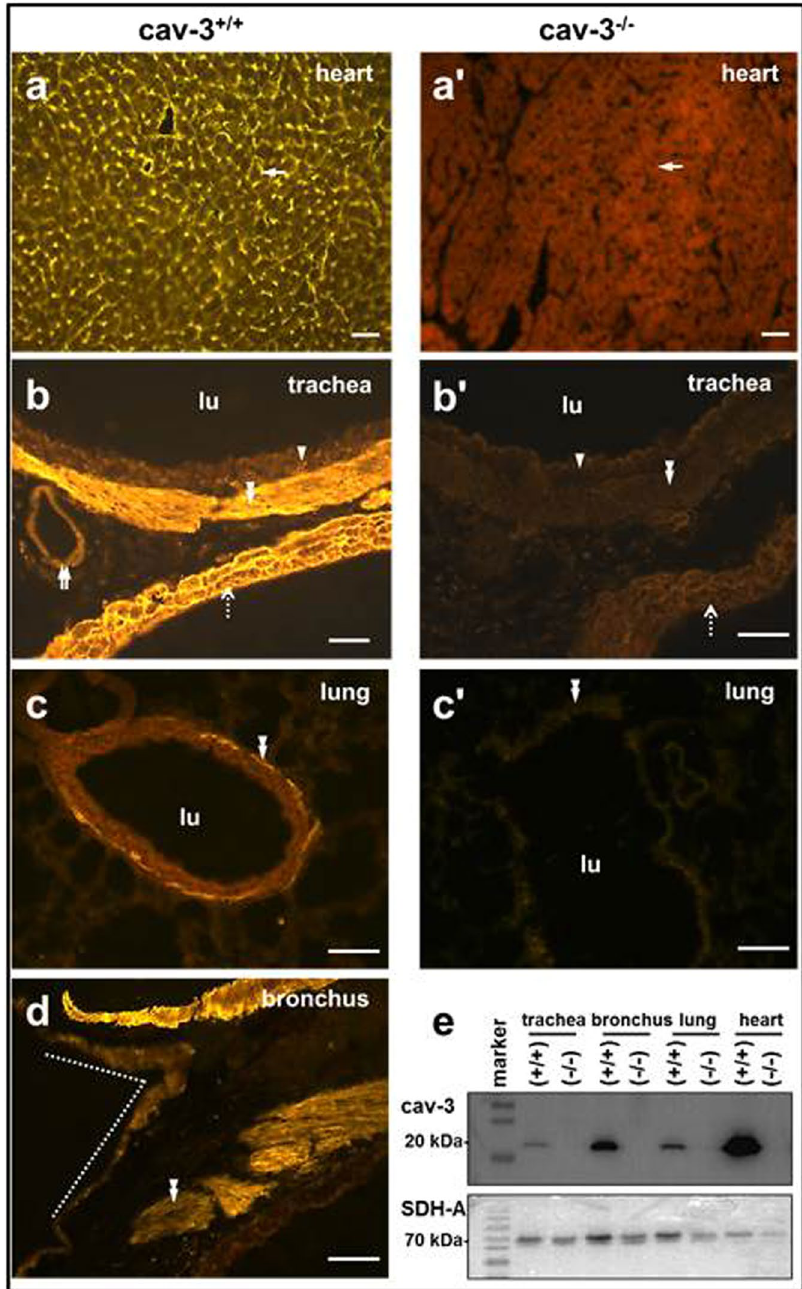
Figure 1. Immunofluorescence labelling for cav-3 in cav-3 + / + and cav-3 − / − mice. Representative images for cav-3 + / + ( n = 4 animals) and cav-3 − / − mice ( n = 5 animals). ( a – d ) Cav-3 immunoreactivity is seen in the cardiac muscle cells (arrow), tracheal epithelium (arrowhead), tracheal and bronchial SMC (double arrowhead), and cardiomyocytes of the pulmonary vein (dashed arrow) and arterial smooth muscle (double arrow) in cav-3 + / + mice. ( d ) SMC are shown in the left extrapulmonary bronchus and the tracheal bifurcation is also shown by a dotted line. No cav-3 labelling is noted in cav-3 − / − mice. Bar = 50 µ m. ( e ) Specificity control of the anti-cav-3 antibody. No cav-3 immunolabelling is present in cav-3 − / − mouse samples, while the antibody recognizes a single 20 kDa protein band in protein extracts from cav-3 + / + mouse samples. Our own laboratory polyclonal antibody to succinate dehydrogenase complex, subunit A (SDH-A) labels a protein band at 70 kDa in all cav- 3 − / − and cav-3 + / + mouse samples as a reference